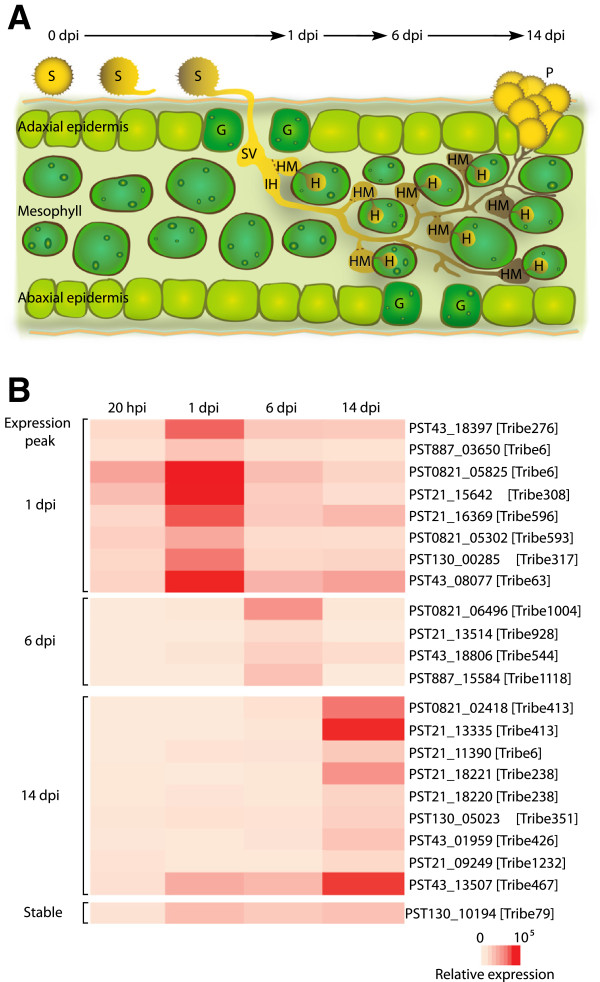
Quantitative RT-PCR revealed peaks of expression for the selected effector candidates during plant infection. A. Schematic representation of the stages of PST development during plant infection. B. Quantitative RT-PCR was undertaken at four stages of PST-08/21 infection for a subset of 22 effector candidates. Three peaks of expression were noted at 1 day post-inoculation (dpi), 6 dpi and 14 dpi. hpi, hours post-inoculation; S, uredinospore; SV, substomatal vesicle; IH, invasive hyphae; HM, haustorial mother cell; H, haustorium; P, pustule; G, guard cell.